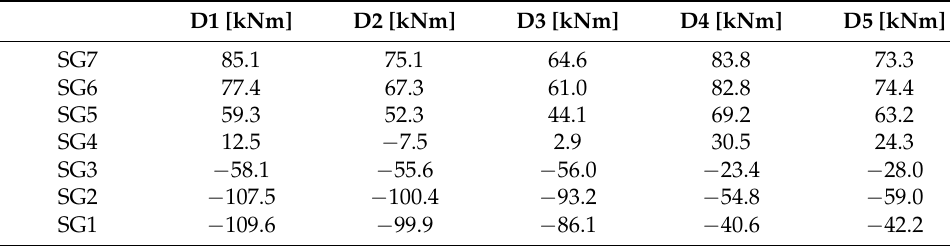
Table 6. Strain gauge measurement results.